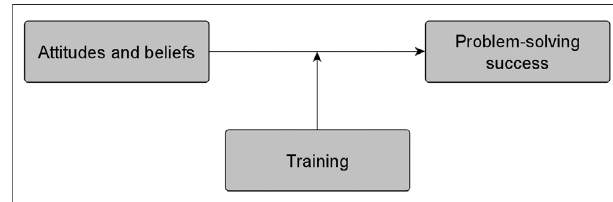
FIGURE 1 | The moderation model with the single moderator variable training in fl uencing the effect of attitudes and beliefs on problem-solving